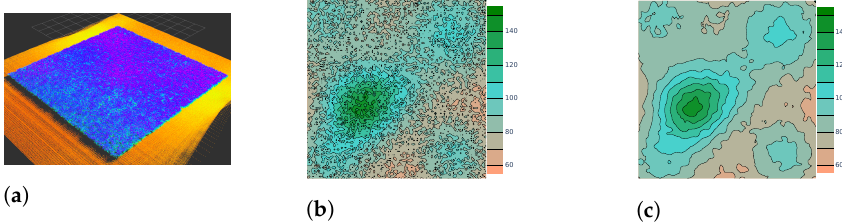
Figure 3. ( a ) Gazebo point cloud surface as measured in Gazebo with a hector quad-copter equipped with LIDAR; ( b ) raw measurements (mm) on the Gazebo point cloud in ( a ) in a contour plot; ( c ) processed (filtered) measurements (mm) adapted for neural network